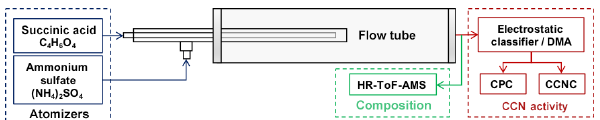
Figure 1. External and internal mixtures with gradual mixing in flow